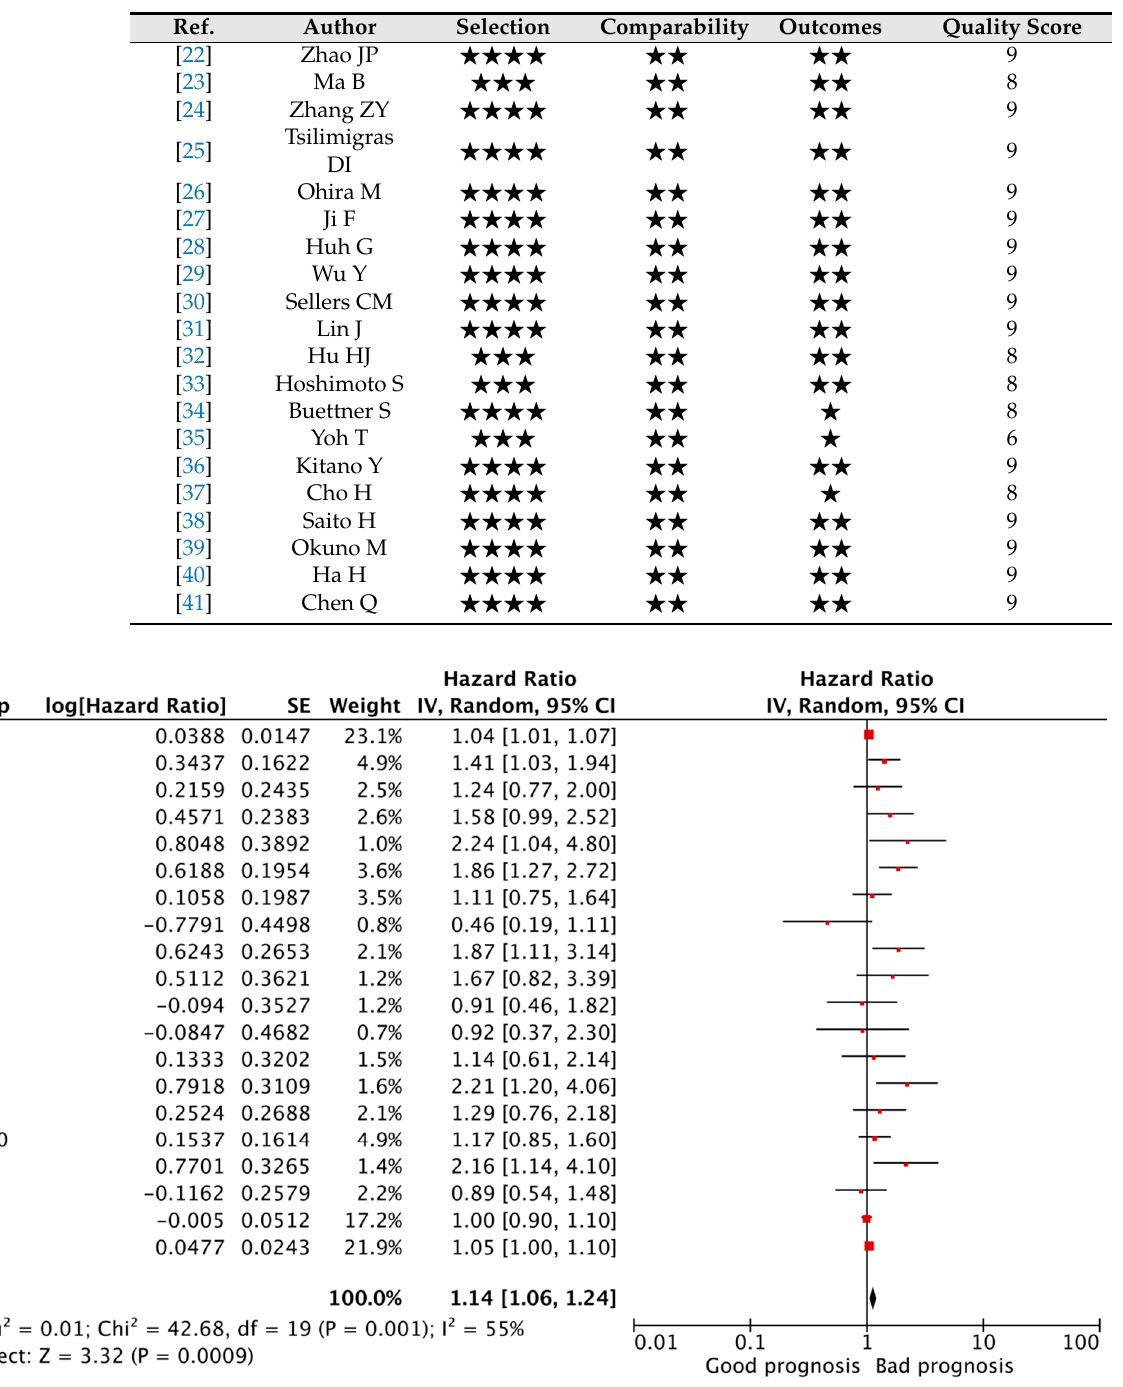
Figure 2. Forest plot of the correlation between PLR and OS in CCA patients. A random-effects model was used to estimate the relationship between PLR and OS. OS, overall survival; PLR, platelet-to-lymphocyte ratio.